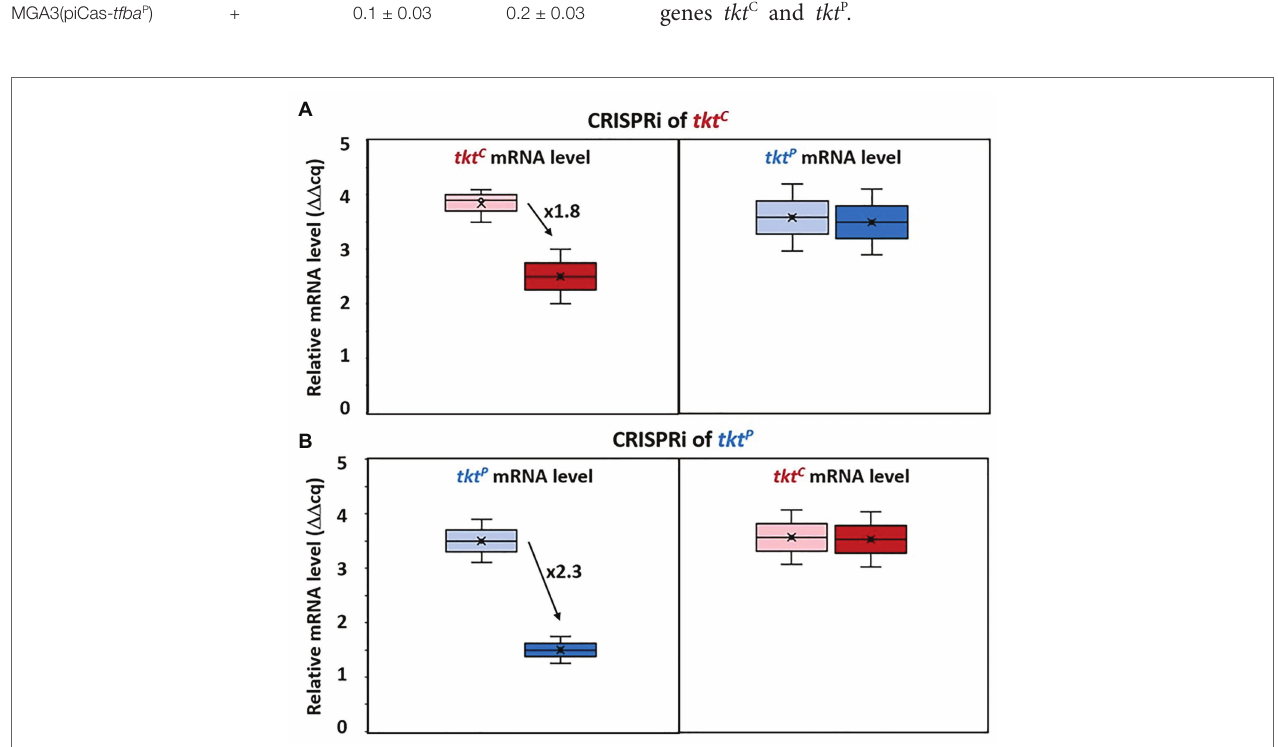
FIGURE 4 | Changed gene expression levels due to dCas9 targeting tkt C and tkt P . Relative mRNA levels of tkt C (left) and tkt P (right) in MGA3(piCas- ttkt C ) (A) and relative mRNA level of tkt P (left) and tkt C (right) in MGA3(piCas- ttkt P ) (B) are shown by Box and Whisker plots as detected by qRT-PCR. Black arrows with adjacent numbers indicate up- or downregulation without (lighter color, left) and with (darker color, right) CRISPRi